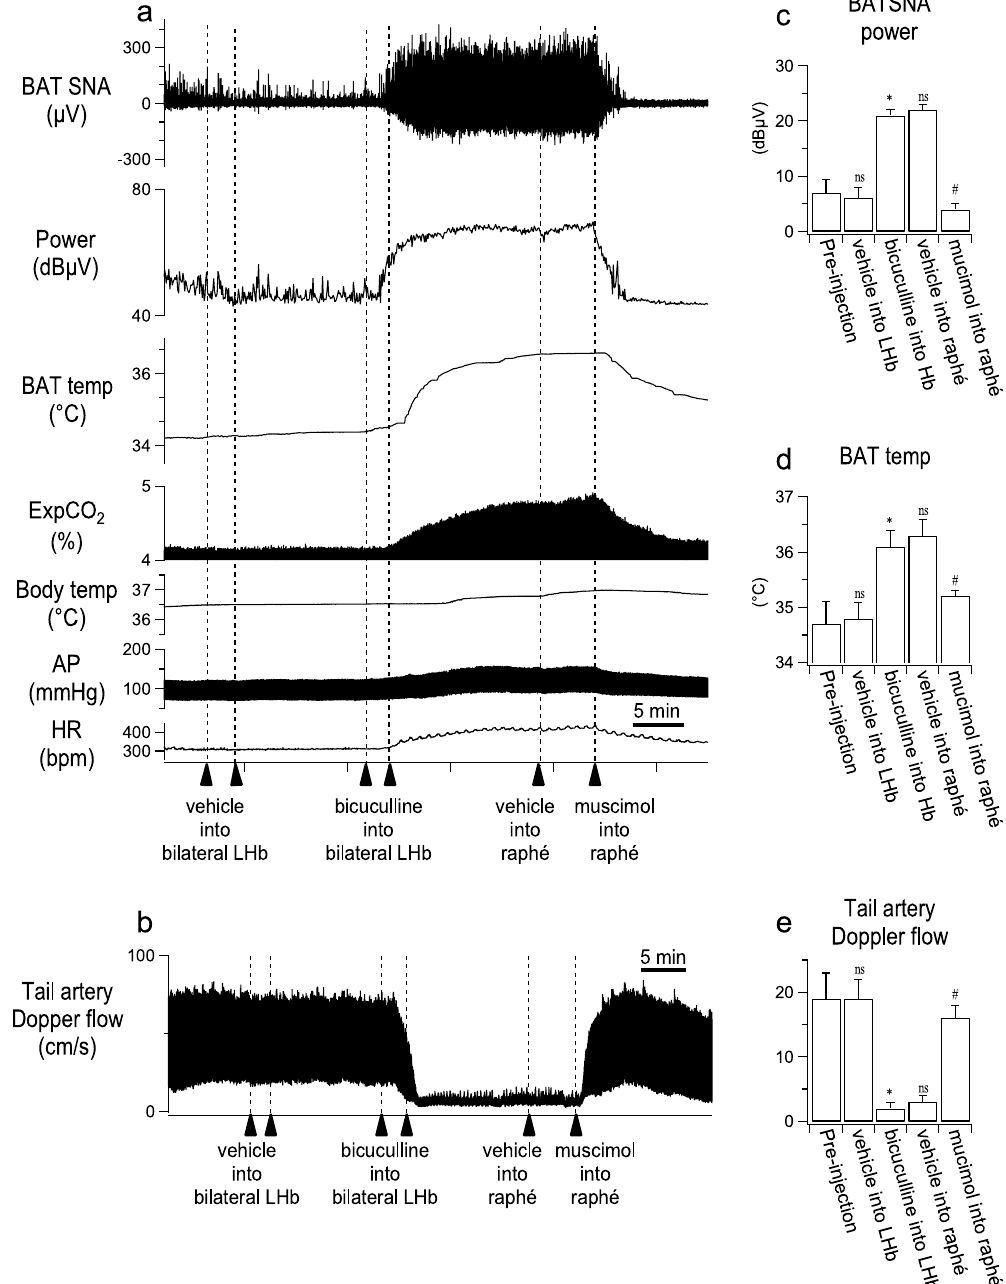
Figure 2. Effect of muscimol injection (0.5 nmol in 50 nl) into the medullary raphé on autonomic response elicited by bilateral injections of bicuculline (1 nmol in 100 nl) into the LHb. ( a ) Chart records of simultaneously recorded brown adipose tissue sympathetic nerve discharge (BAT SNA), its spectral power, BAT temperature (BAT temp), end expiratory CO 2 (ExpCO 2 ), body temperature (Body temp), arterial pressure (AP) and heart rate (HR). ( b and c ) Group data (mean ± SEM) for mean effects of vehicle/drug on BAT SNA power and BAT temperature. ( d ) Chart record of tail artery Doppler flow signal. ( e ) Group data (mean ± SEM) for mean effects of vehicle/drug on tail artery Doppler flow. In a and d , sequential experimental manipulations of LHb and medullary raphé function are indicated by the vertical arrows. ‘ns’ not significantly different from the preceding injection level (pre-injection or bicuculline into LHb), P > 0.05; * significant different from the pre-injection value, P < 0.001; # significant different from the post-bicuculline value, P <